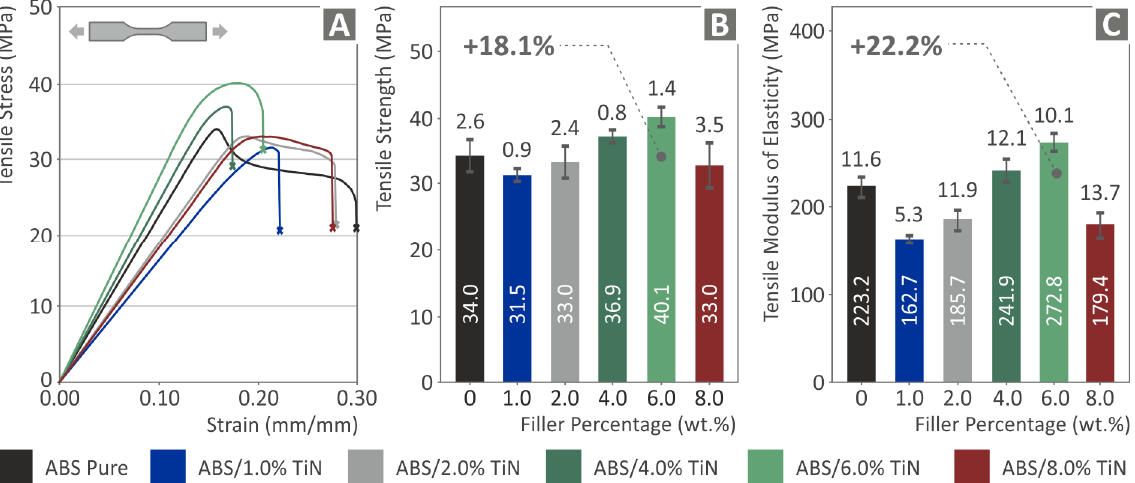
Figure 8. Tensile tests of the six 3D-printed specimens: ( A ) tensile stress vs. strain graph of one randomly selected specimen of the five tested in each nano compound, average values, and deviation of the ( B ) tensile strength results, and ( C ) tensile modulus of elasticity results.